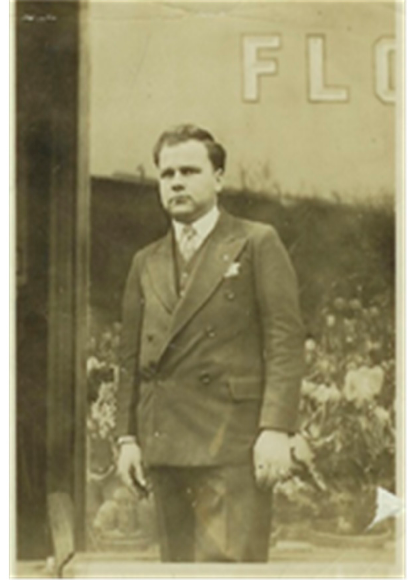
Figure 4. Mitsos in front of his store (courtesy of Victoria P).